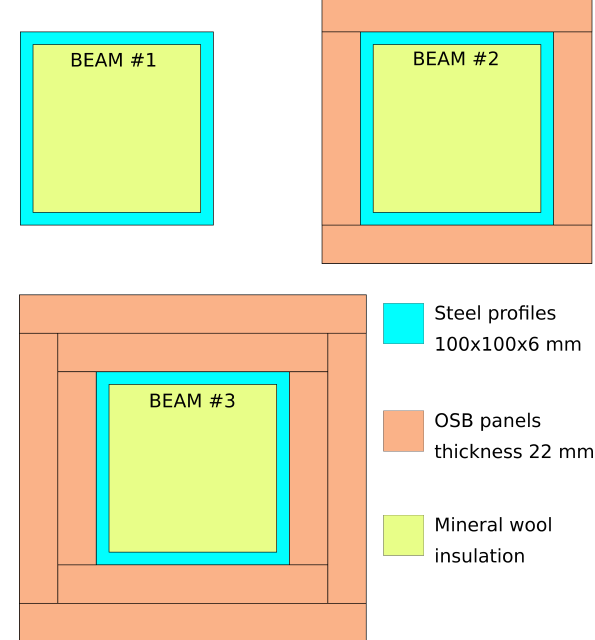
Figure 2. Cross sections of the